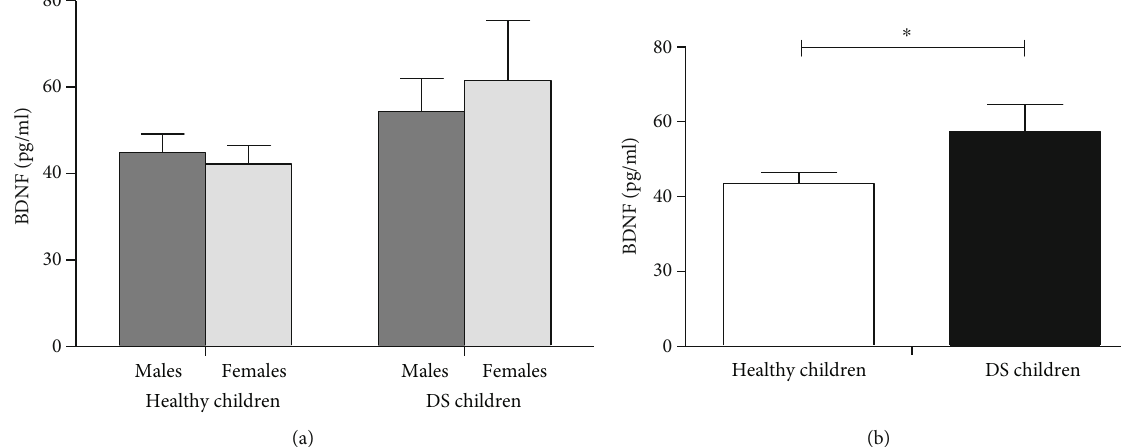
Figure 2: Brain-derived neurotrophic factor (BDNF) levels in male and female DS prepubertal children and in the control group ((a) shows the data according to gender but (b) are without it). The error bars indicate pooled standard error means (SEM) derived from appropriate error mean square in the ANOVA. The asterisk indicates signi fi cant di ff erences between groups ( ∗ p < 0 : 05 ).